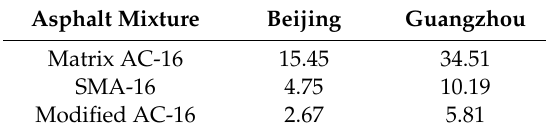
Table 3. Temperature rutting rates of asphalt mixture in Beijing and Guangzhou (unit: 10 − 5 mm/load times).